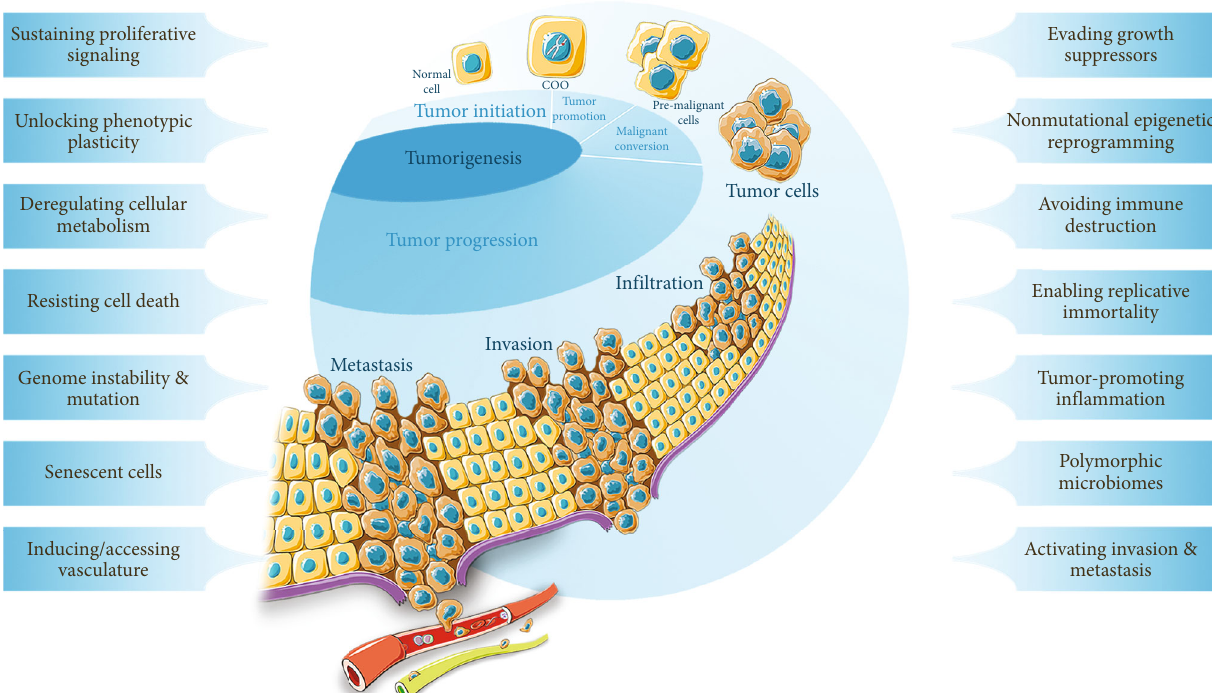
Figure 1: Steps of tumorigenesis and the hallmarks of cancer. A normal cell is transformed into cell-of-origin (COO) after receiving the fi rst oncogenic mutation (tumor initiation). COOs subsequently develop into pre-malignant cells (tumor promotion) and undergo the malignant conversion; they fi nally enter the tumor progression stage (including tumor in fi ltration, invasion, and metastasis). During the process, cancers obtain a series of hallmarks and characteristics involving “ sustaining proliferative signaling, ” “ evading growth suppressors, ” “ resisting cell death, ” “ enabling replicative immortality, ” “ inducing or accessing vasculature, ” “ activating invasion and metastasis, ” “ deregulating cellular metabolism, ” “ avoiding immune destruction, ” “ unlocking phenotypic plasticity, ” “ nonmutational epigenetic reprogramming, ” “ polymorphic microbiomes, ” and “ senescent cells.